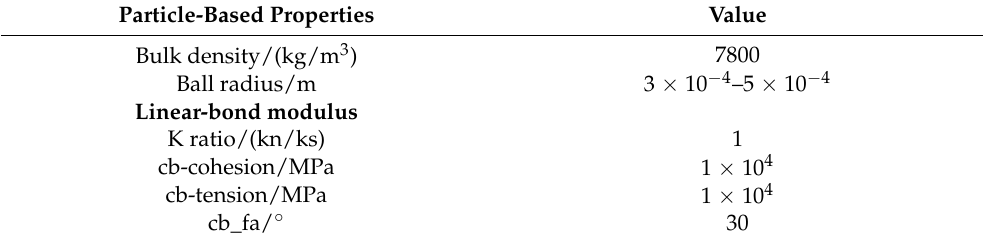
Table 2. Micro-parameters of incident/transmitted bar after calibration.